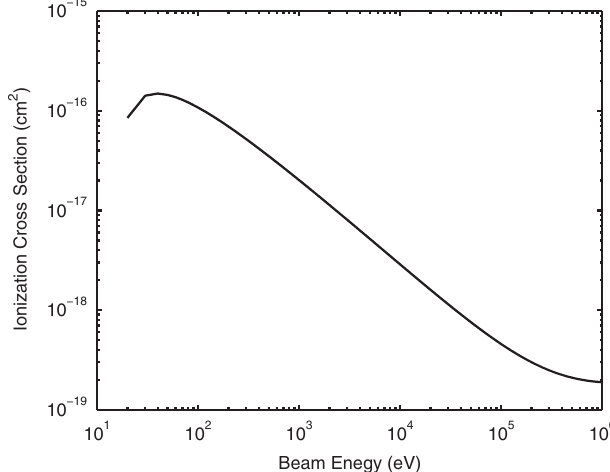
FIG. 6. H 2 ionization cross section as a function of the beam